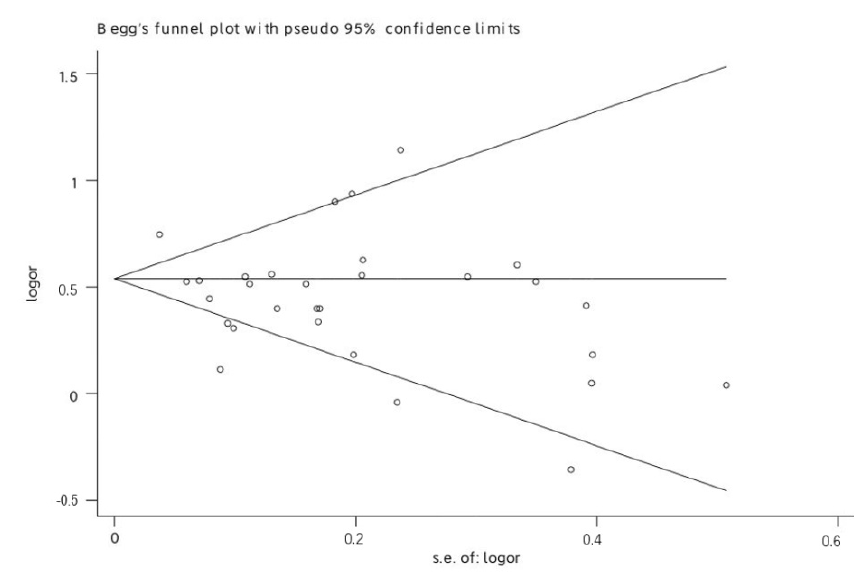
Figure 3. Funnel plot of publication bias.